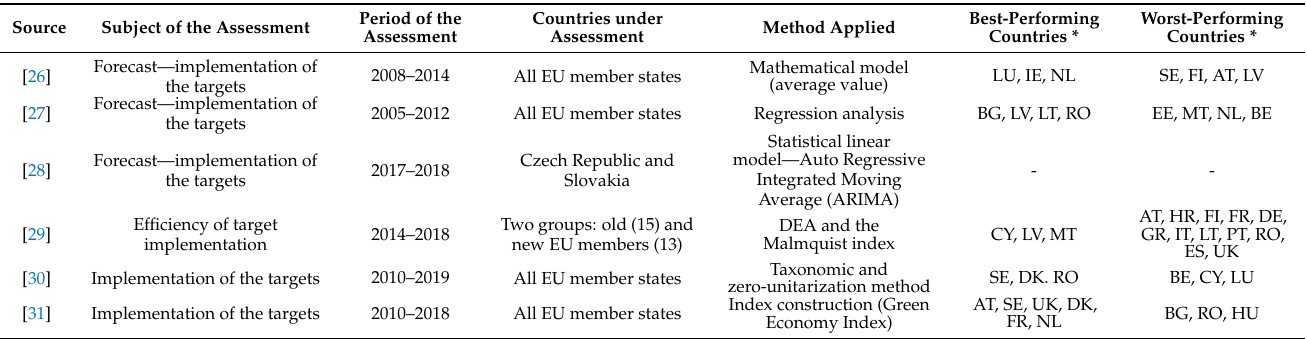
Table 1. The results summary of studies ranking climate change and energy achievements among